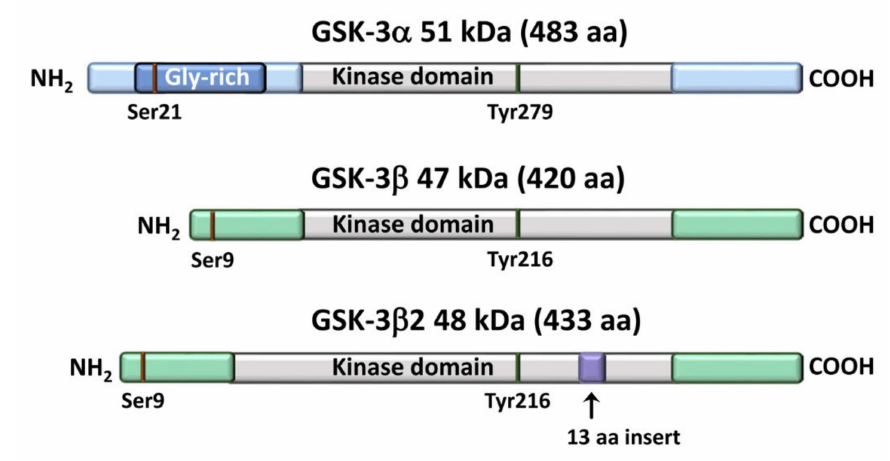
Figure 1. Structural domains and main sites of phosphorylation of GSK-3 isoforms. Differently from most protein kinases, GSK-3 isoforms are constitutively active in resting cells, partly due to autophosphorylation of GSK-3 α on Tyr279 and of GSK-3 β on Tyr216. These phosphorylations, which take place during GSK-3 translation, upregulate